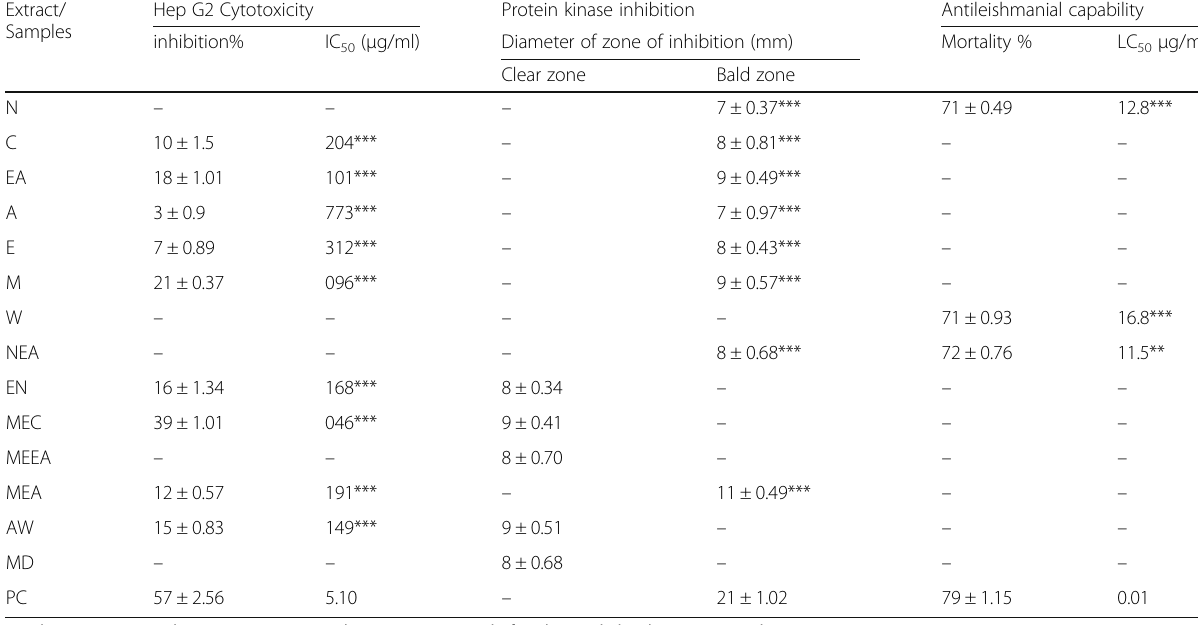
Table 5 HepG2 Cytotoxicity, Streptomyces hyphae formation inhibition and Anti-leishmanial capability of various solvent extracts Extract/